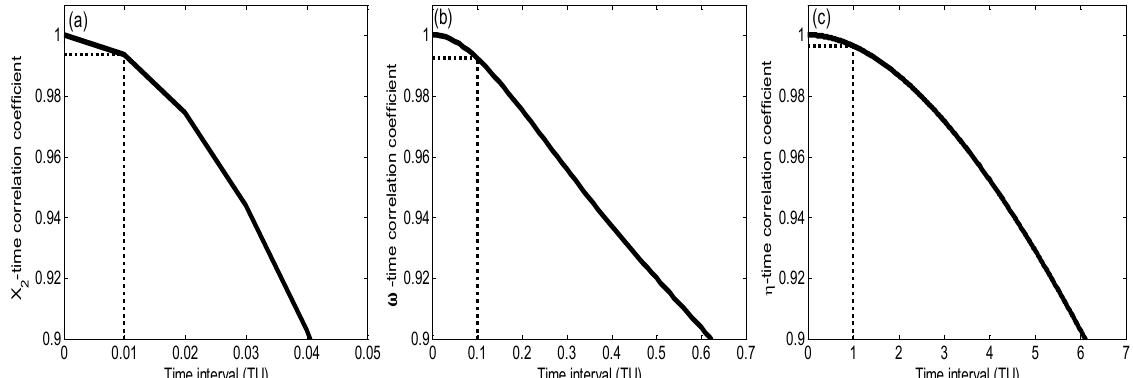
Figure 6. The auto-correlation coefficient of (a) X 2 (b) ω , and (c) η in the space of lag times are marked by corresponding time correlation coefficients at the timescale ( L ) of optimal OTWs as detected by Fig. 4 for different media (the black-dashed lines). What are shown are the means of 20 cases. In each case, an independent section (each has 10000 data of the state – 100TUs with the interval of 0.01TU) is used to evaluate the lag correlation coefficient. The 20 independent sections are taken from the model states apart each 200TUs between 5000 and 9000TUs integrations after the spinup of 10000TUs from the initial condition (0, 1, 0, 0, 0).